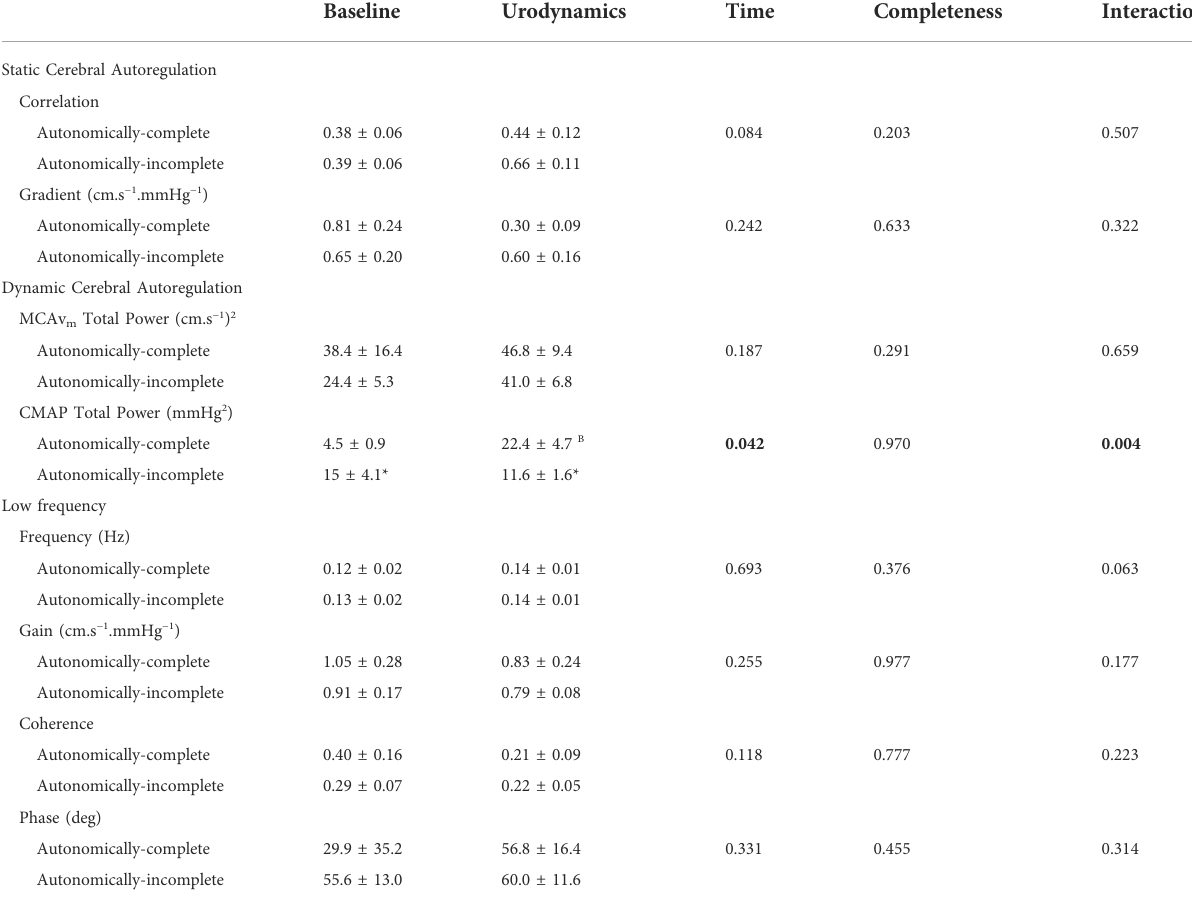
TABLE 2 Measures of static and dynamic cerebral autoregulation at baseline and during